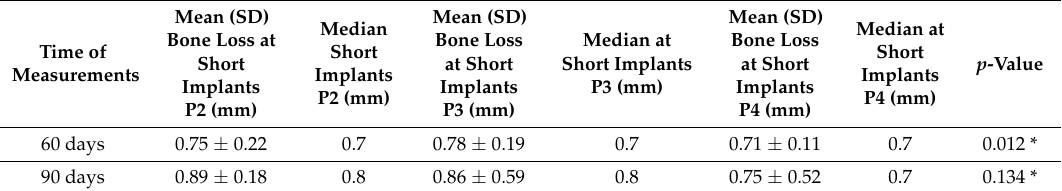
Table 4. Bone loss at 60 days and 90 days of the extra-short narrow ring implant.